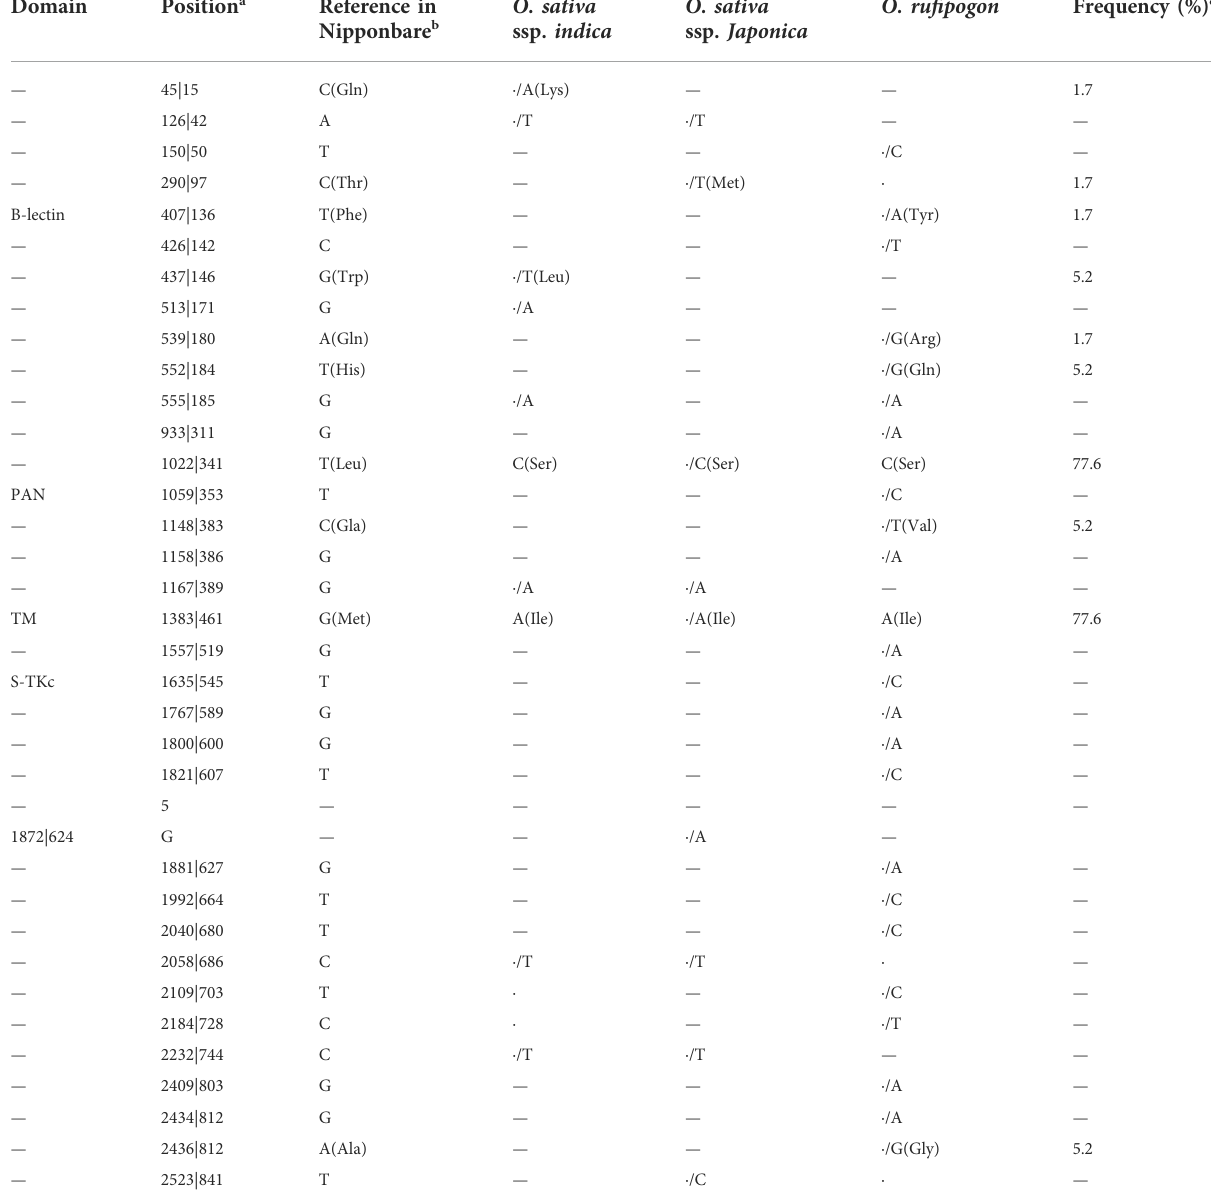
TABLE 1 Polymorphic sites of Pi-d2 in different rice